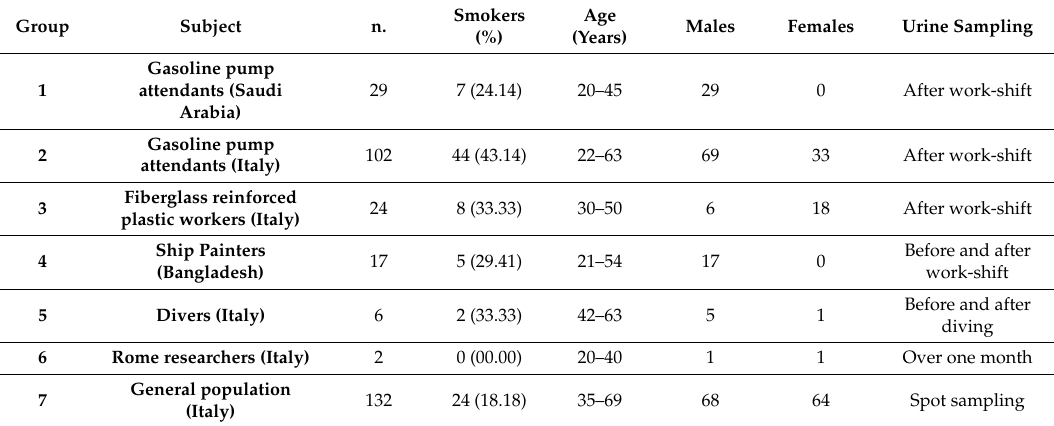
Table 1. Characteristic of the study groups.